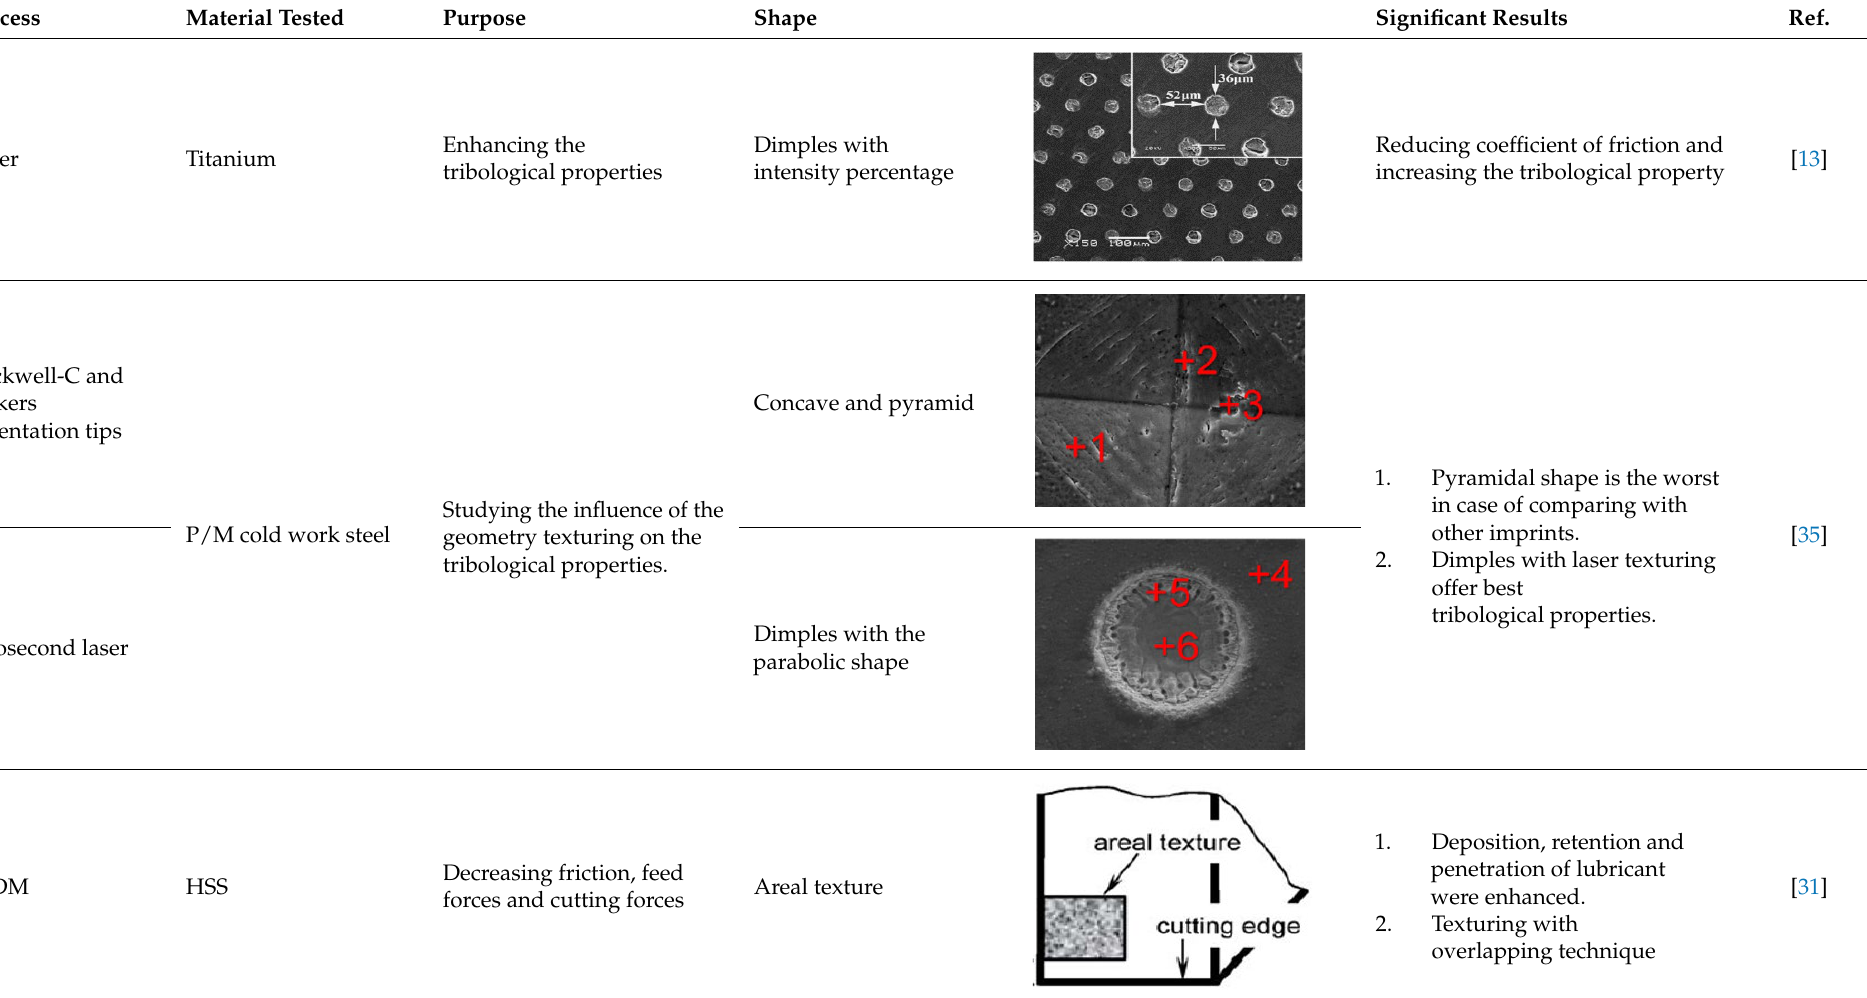
Table A2. The most common methods for creating textures on surfaces of different materials and cutting tools.